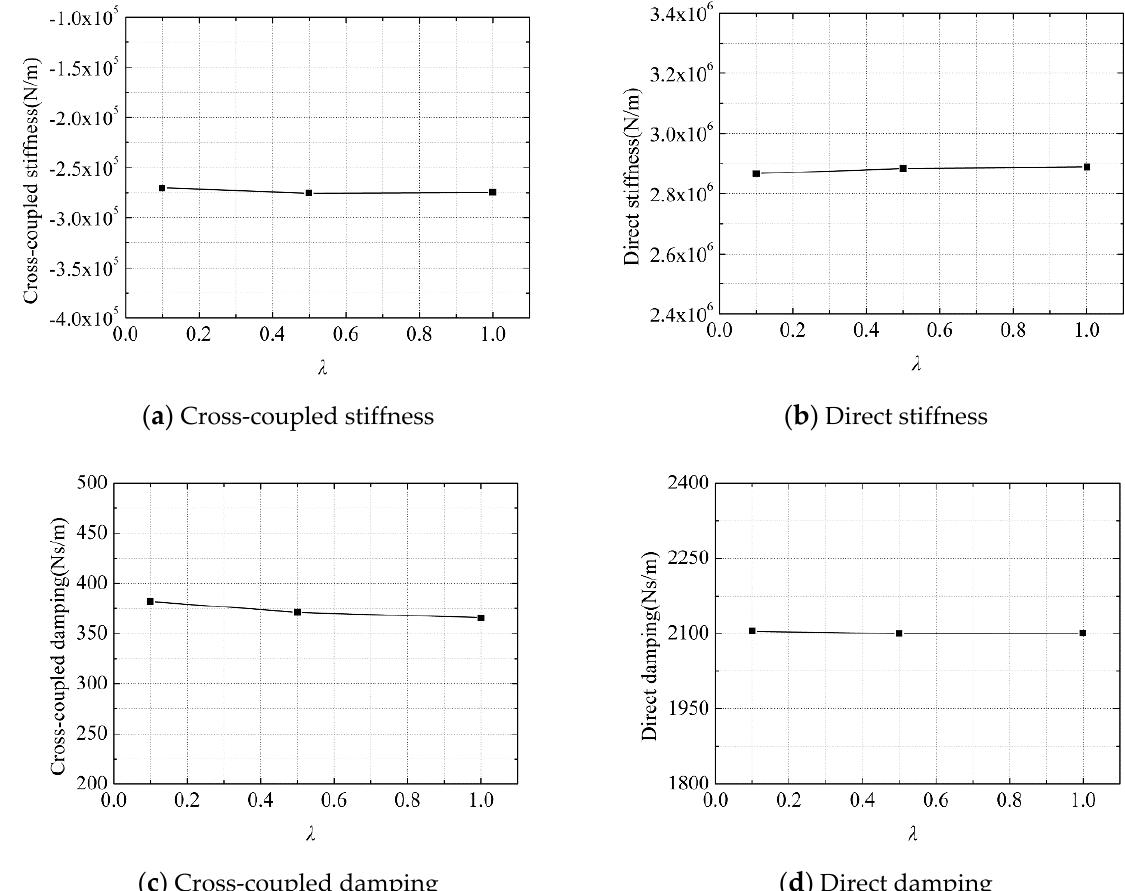
Figure 17. Variations in rotordynamic coefficients with ellipticity.